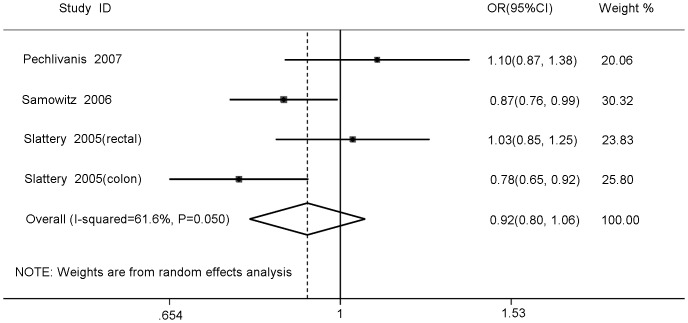
Forest plots for meta-analysis of the association between IRS2 rs1805097 polymorphism and colorectal cancer risk under dominant model (A/A+A/G vs. G/G).